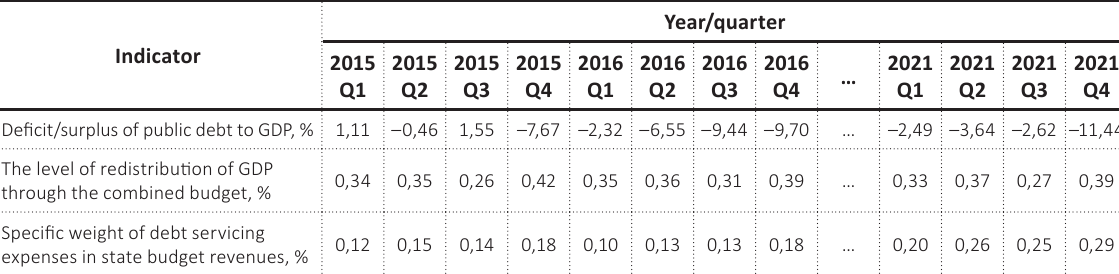
Table А4. Normalized values of indicators for the budgetary security of Ukraine Indicator